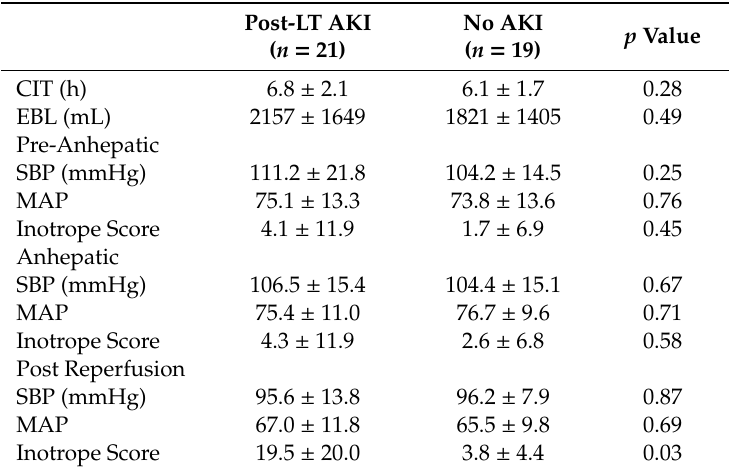
Figure 2. Post-Liver Transplant Patterns in Steatotic and Non-Steatotic Grafts. ( A ) Post-LT aspartate aminotransferase (AST) levels. Compared to non-steatotic graft, AST levels were 2-times higher in steatotic grafts without post-LT AKI and 4-times higher for steatotic grafts with AKI. ( B ) Post-LT creatinine levels. Table 3. Steatotic Graft Recipient Operative Variables.